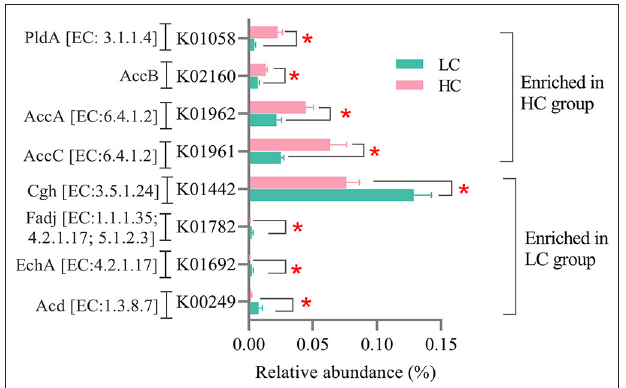
FIGURE 6 | Effects of high-concentrate (HC) feeding on microbial genes involved in the lipid metabolism of dairy cows. * p <